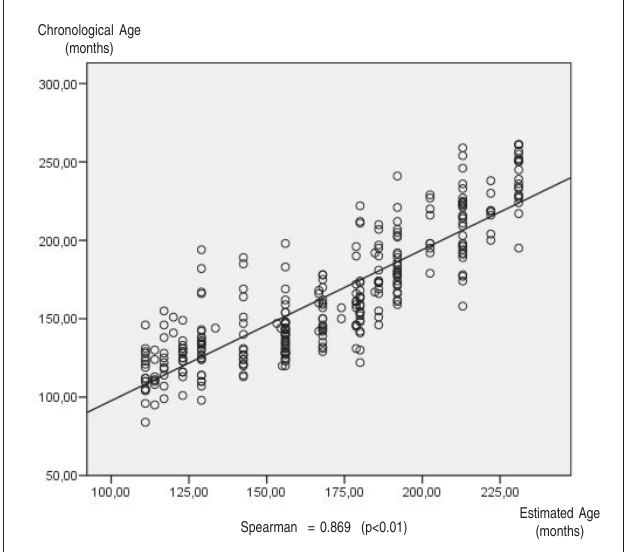
Fig. 2. Linear regression curve correlating estimated and chronological ages. (Lower third molar mineralization evaluation).